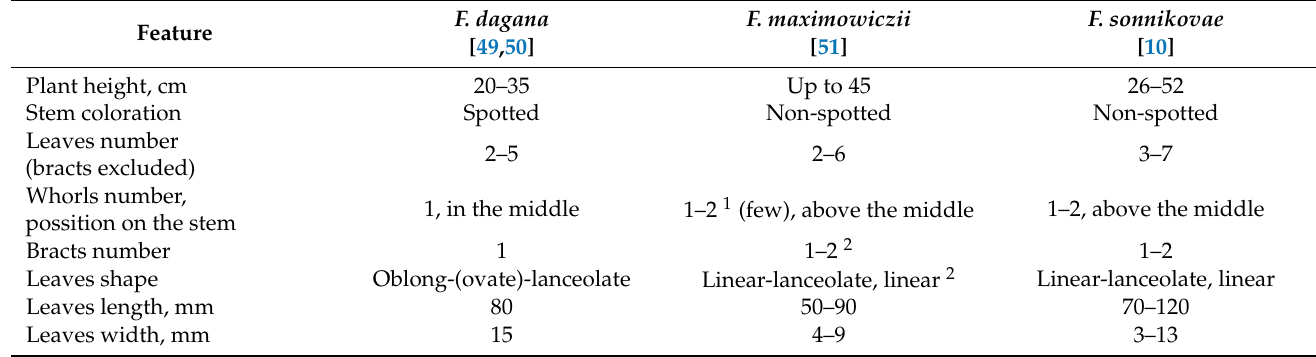
Table 3. Comparative morphological features of three closely related Fritillaria